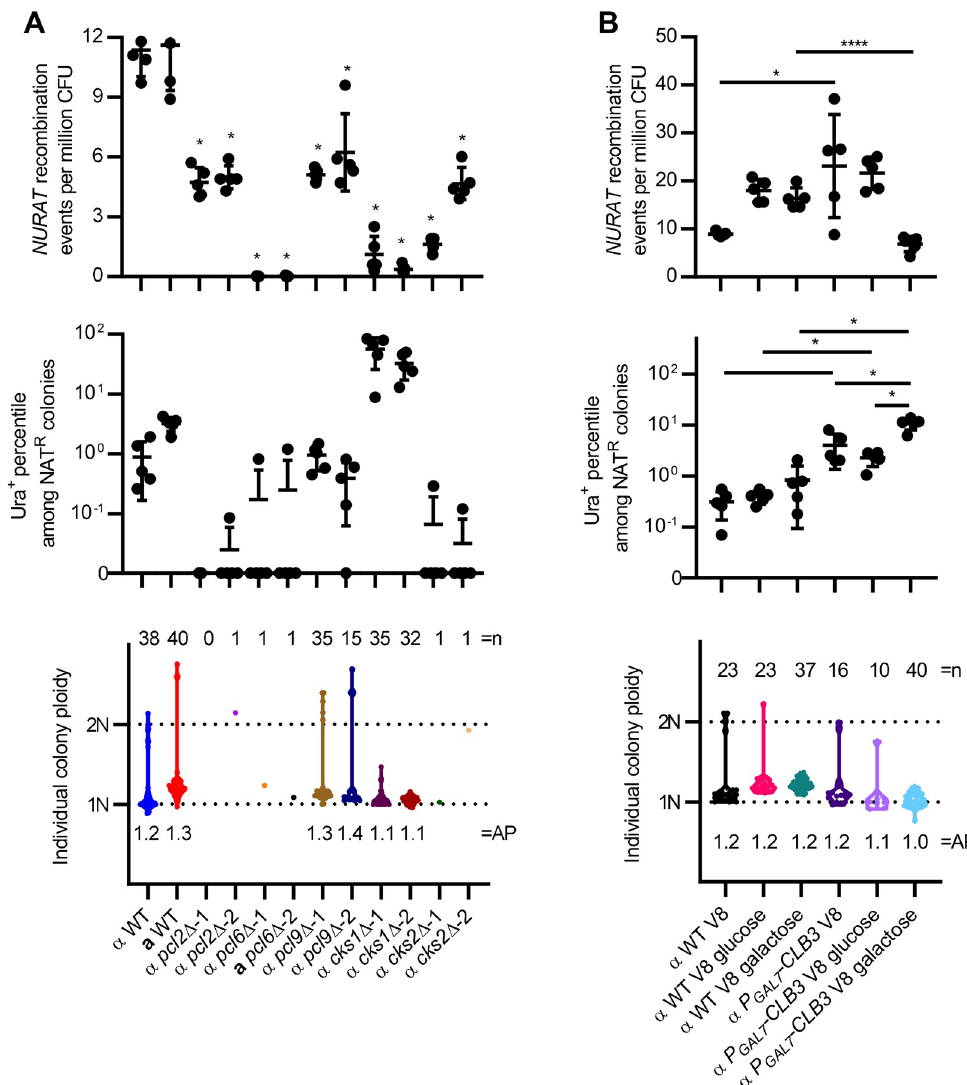
Fig 5. Cell cycle regulating genes contribute to segmental aneuploid formation. (A) Deletion of PCL2 , PCL6 , PCL9 , CKS1 , and CKS2 reduced NURAT recombination frequency; deletion of CKS1 increased the percentile of NURAT presence among NAT R colonies; deletion of PCL2 , PCL6 , and CKS2 blocked segmental aneuploidy formation. Student’s t- test with Bonferroni correction for 10 repeated tests was performed to compare each mutant with the wild type. p value lower than 0.005 ( � ) was considered statistically significant. (B) Suppressed expression of CLB3 increased NURAT recombination frequency and the percentile of NURAT presence among NAT R colonies, while increased expression of CLB3 reduced NURAT recombination frequencies but increased the percentile of NURAT presence among NAT R colonies. Neither down regulation or up regulation of CLB3 blocked segmental aneuploid formation. Mean values of five independent experiments were plotted for the NURAT recombination frequencies and the Ura + percentiles among NAT R colonies; error bars represent standard deviations. Student’s t-test with Bonferroni correction for 9 repeated tests was performed for each pairwise comparison. p value lower than 0.0056 ( � ) was considered statistically